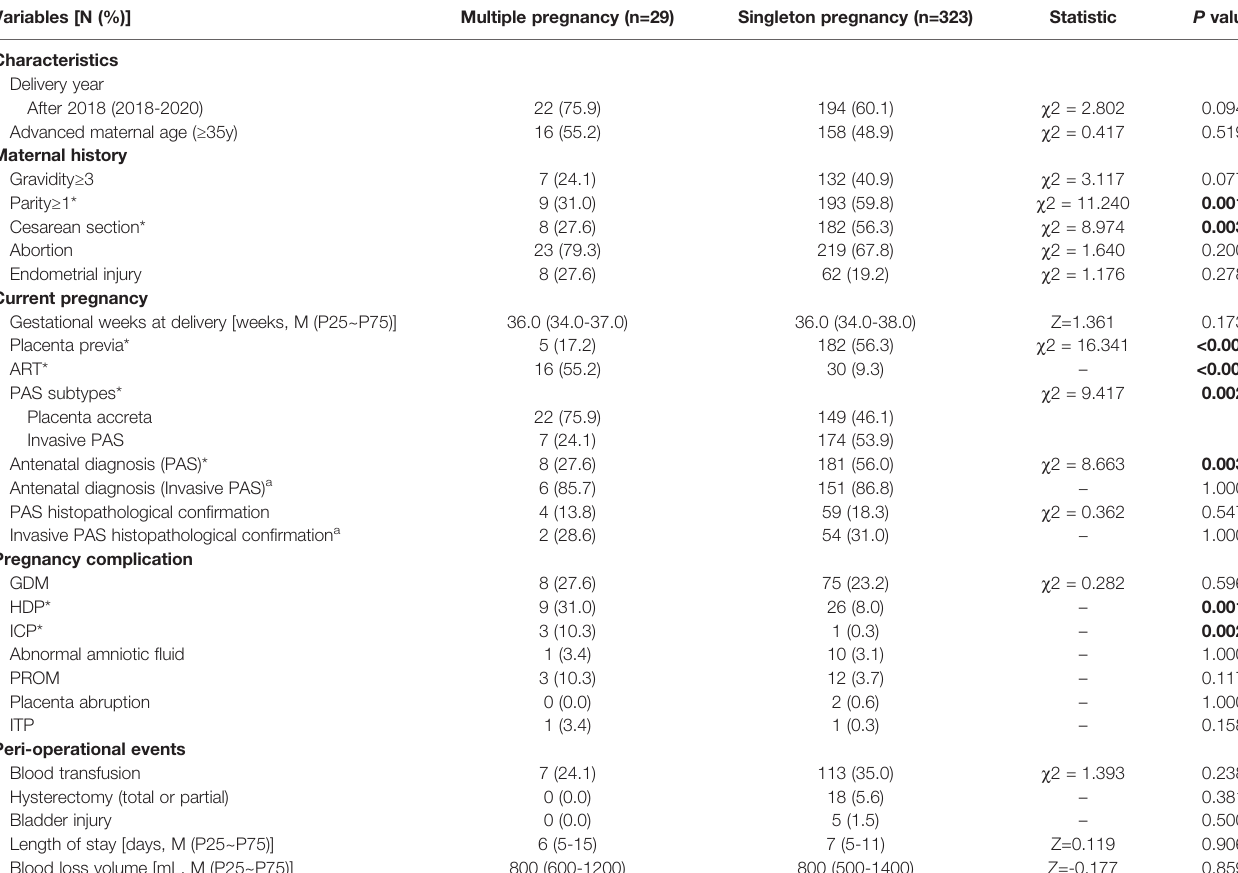
TABLE 3 | Clinical characteristics and perioperative outcomes among PAS patients, strati fi ed by singleton or multiple gestation (N=352). Variables [N (%)] Multiple pregnancy